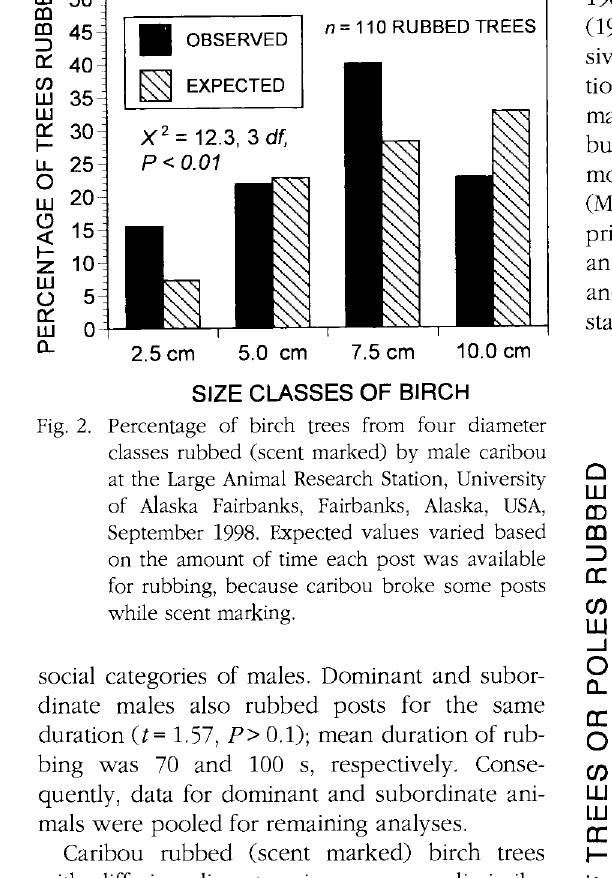
bing was 70 and 100 s, respectively. Conse